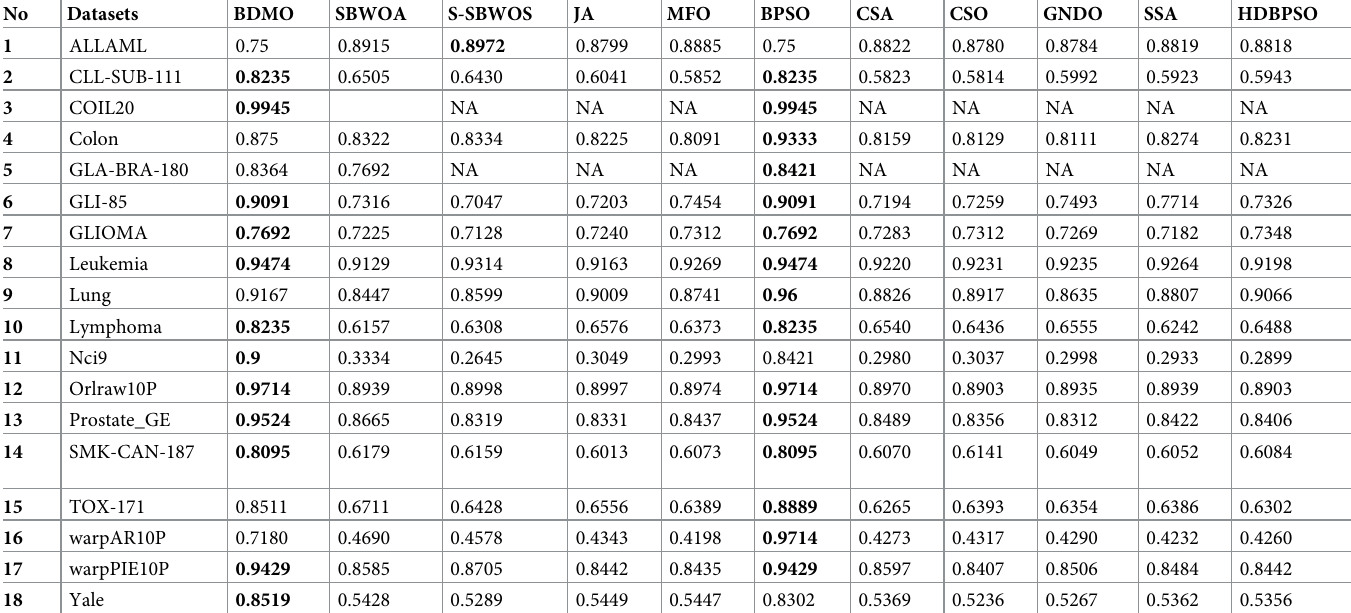
Table 7. F-measure of BDMO and other